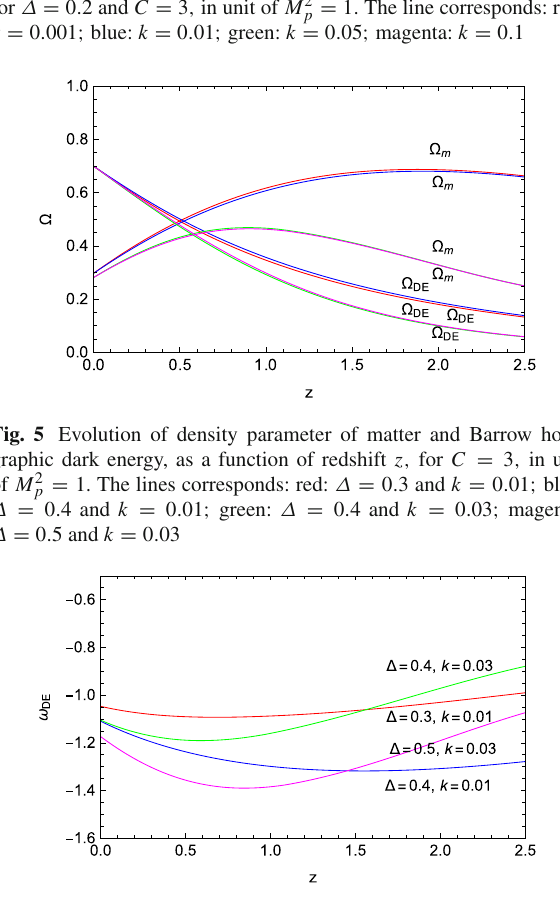
Fig. 6 Evolution of DE EoS parameter, as a function of redshift z , for C = 3 , in unit of M 2 p = 1. The lines corresponds: red: Δ = 0 . 3 and k = 0 . 01 ; blue: Δ = 0 . 4 and k = 0 . 01 ; green: Δ = 0 . 4 and k = 0 . 03 ; magenta: Δ = 0 . 5 and k = 0 . 03